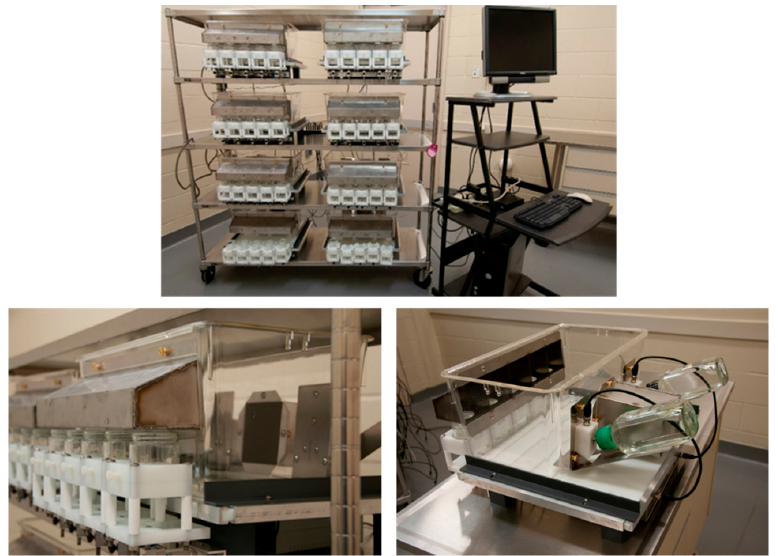
Figure 1. The five-Item Food Choice Monitor. Top: a set of customized cages connected to a computer. Bottom left: the front of a single cage, showing the components to measure food intake—the stainless-steel food hood, glass jars, HDPE jar holders and load cells to measure food intake. Bottom right: the back of a single cage, with the stainless-steel nest flanked by bottles set into the lick blocks, connected by cable to the interface box under the base of the unit.